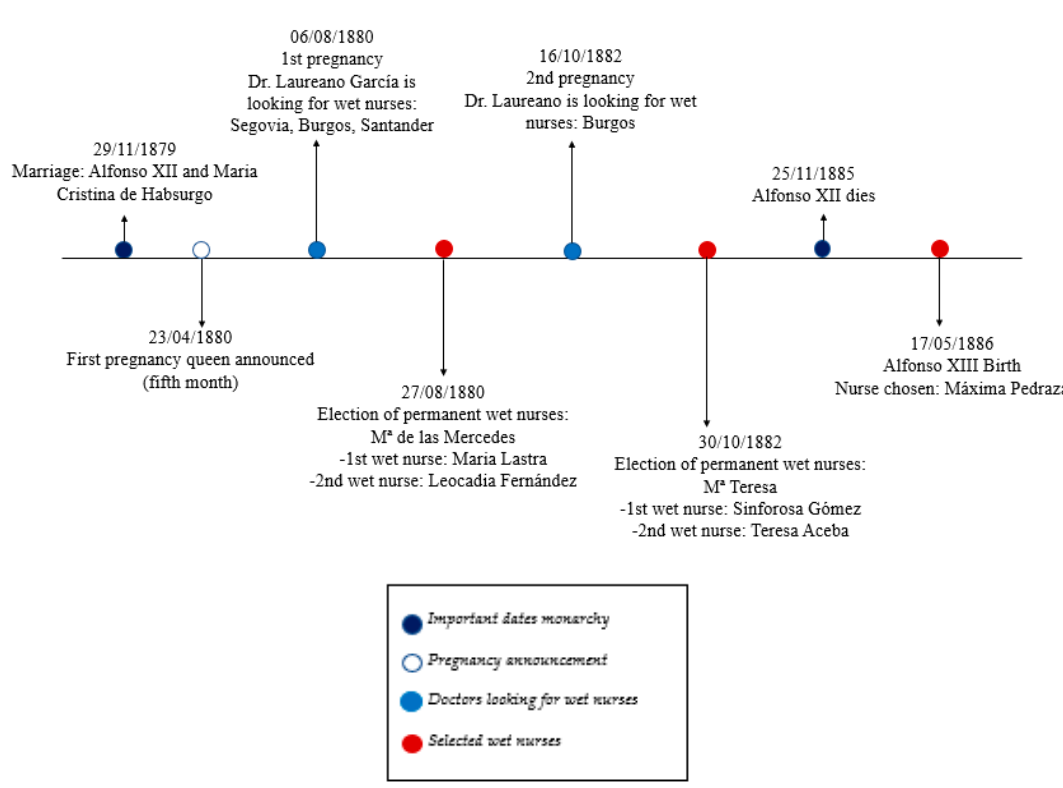
Figure 3. Raising of infants by wet nurses during the reign of Alfonso XII. Source: authors’ own Figure 3. RaisingofinfantsbywetnursesduringthereignofAlfonsoXII.Source: elaboration.